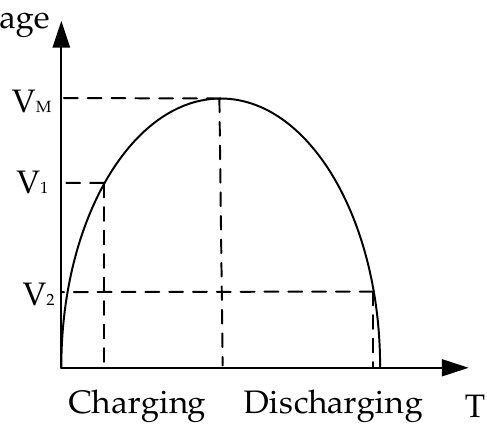
Figure 4. Voltage characteristic of a supercapacitor charging and discharging.